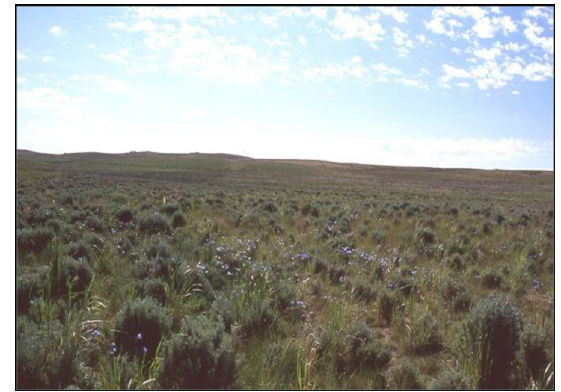
Fig. 11 Strutting activity of the greater sage grouse males (2005– 2007)